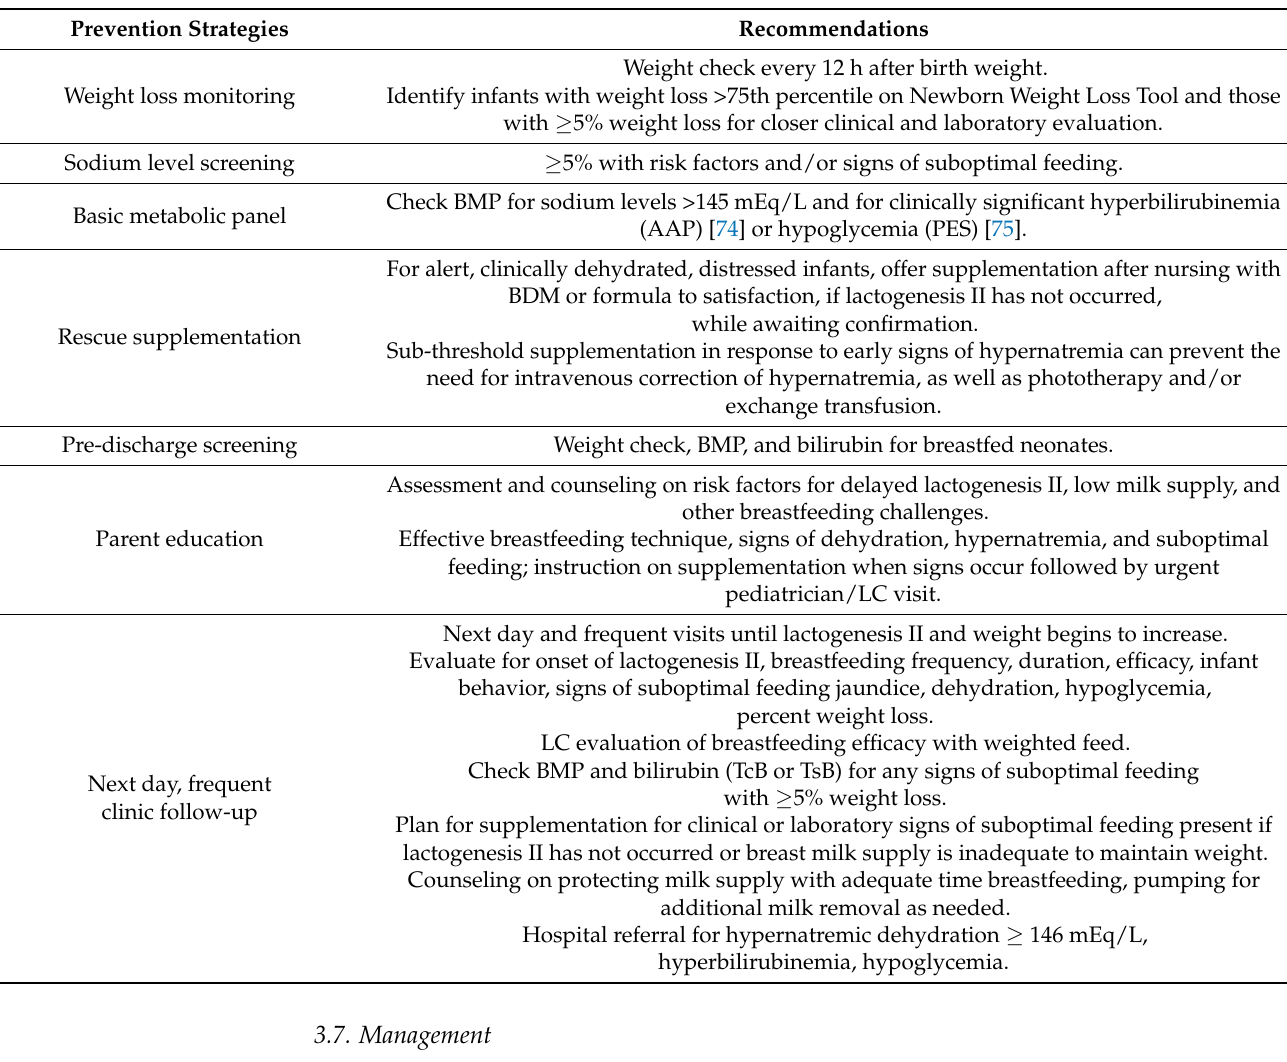
Table 4. Prevention